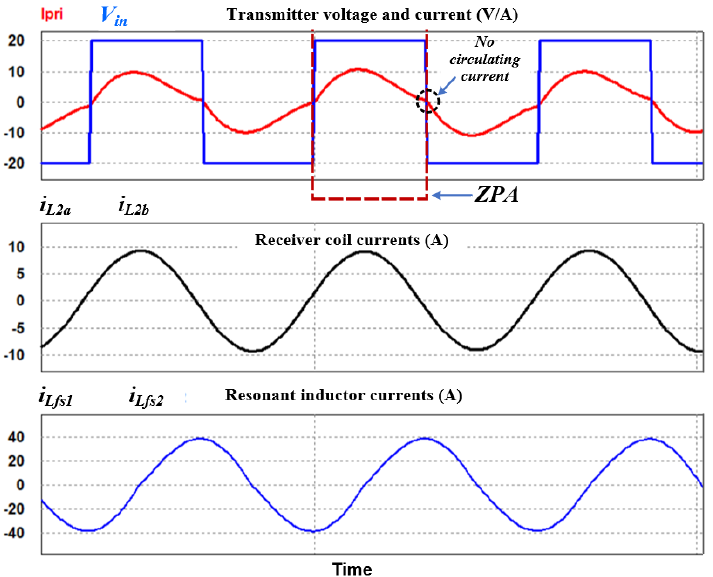
Figure 31. Key simulation waveforms under perfect alignment, zero component tolerance condition.